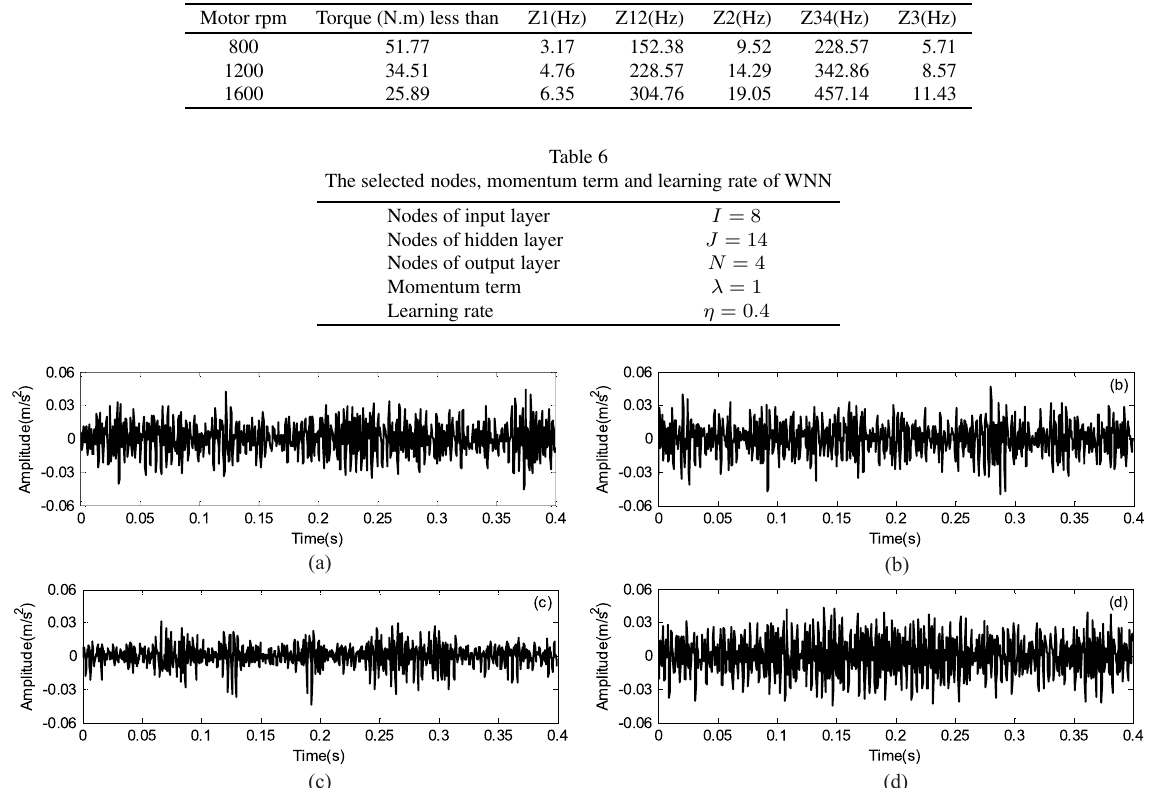
Table 5 Rotational speed and characteristic frequency of the gearbox